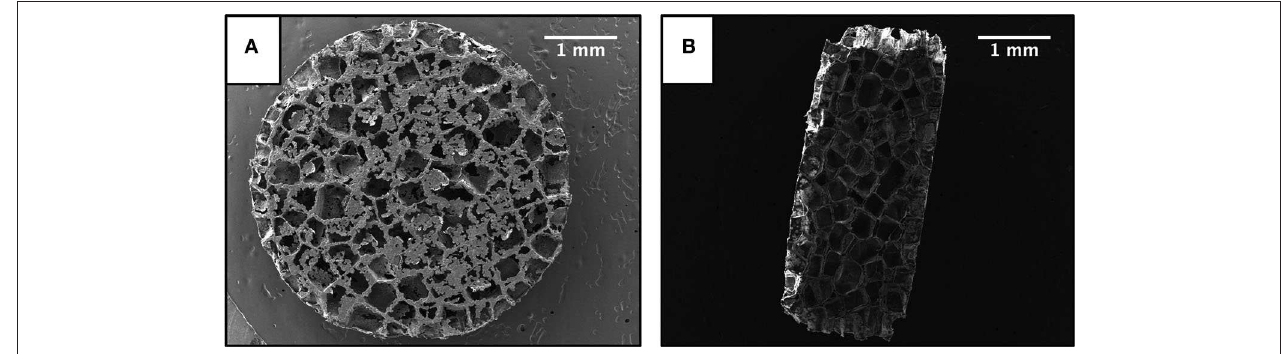
FIGURE 1 | Scanning electron microscope images of a scaffold. (A) Top profile. (B) Cross sectional profile. Scale bar is 1mm.